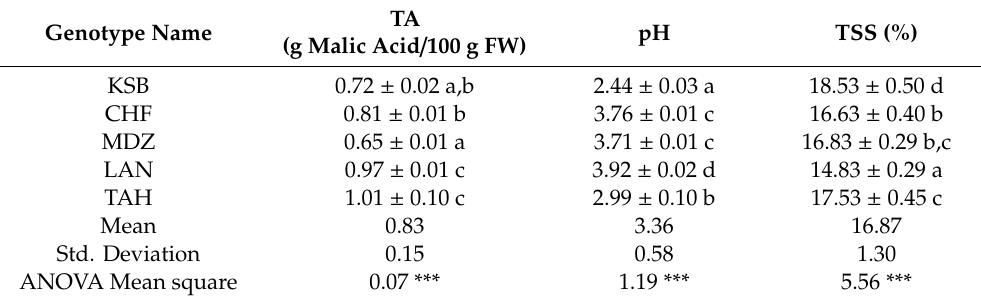
Table 2. Physicochemical parameters in fruits of the strawberry tree